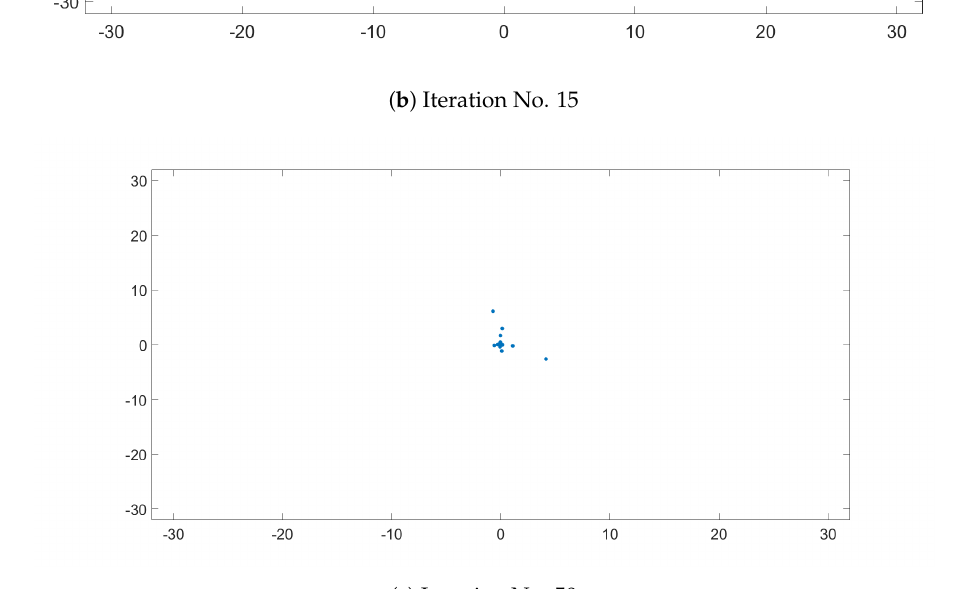
Figure 9. PSO swarm behavior on Ackley’s